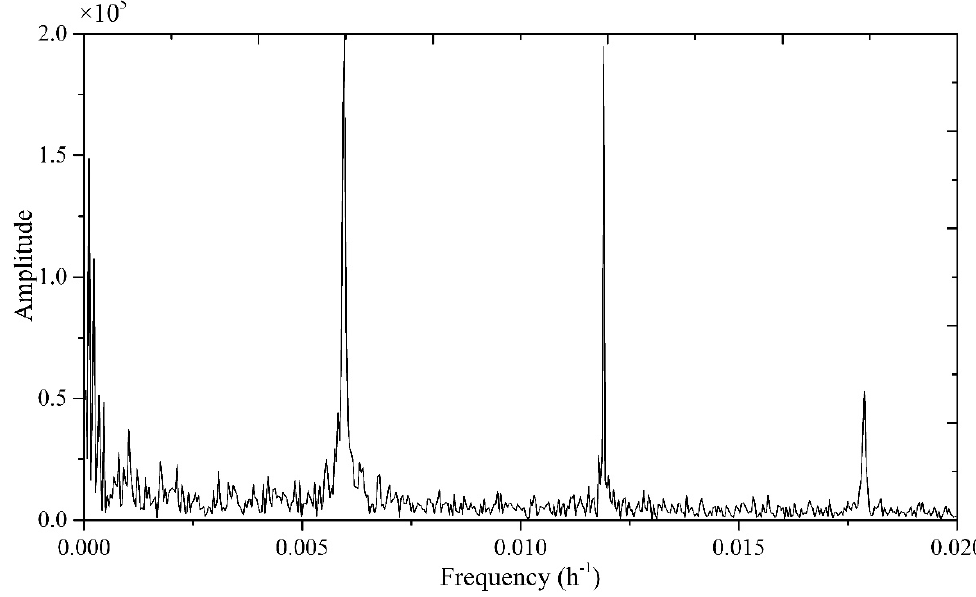
Figure 5. Frequency and amplitude of energy consumption data.